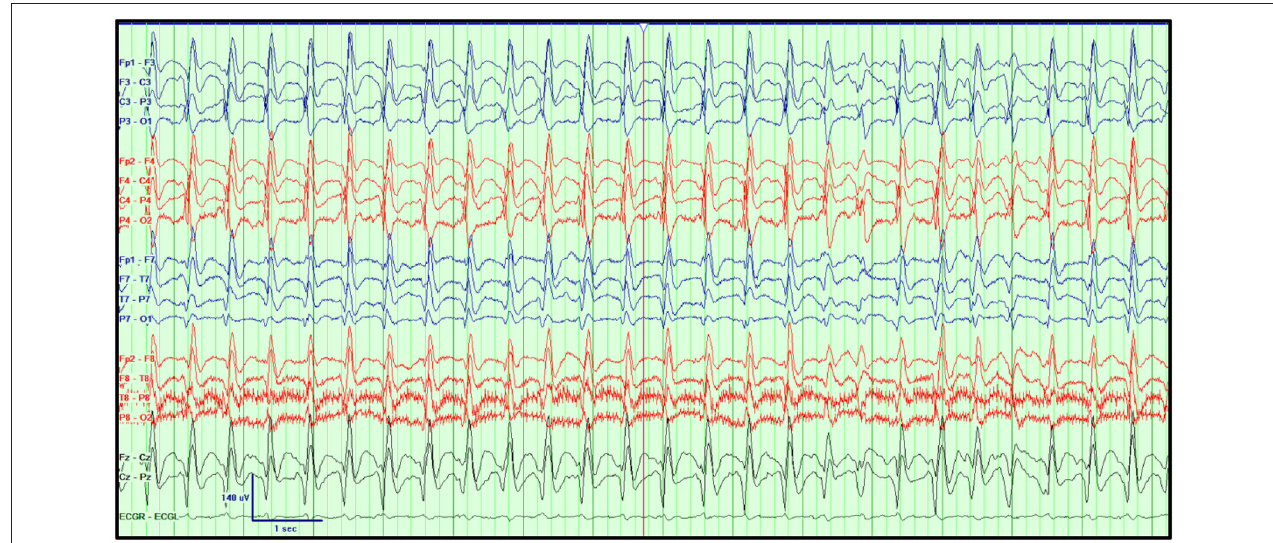
FIGURE 6 | Generalized periodic pattern with triphasic morphology. GPDs with a triphasic morphology at 1–2Hz with a posterior to anterior gradient superimposed over a diffuse, irregular, delta-theta background in a 52-year-old woman with altered mental status, chronic kidney disease and sepsis treated with cefepime. Bipolar montage, LFF: 1Hz, HFF: 70Hz, Notch: 60Hz, Sensitivity: 7 µ V/mm, Timebase: 30